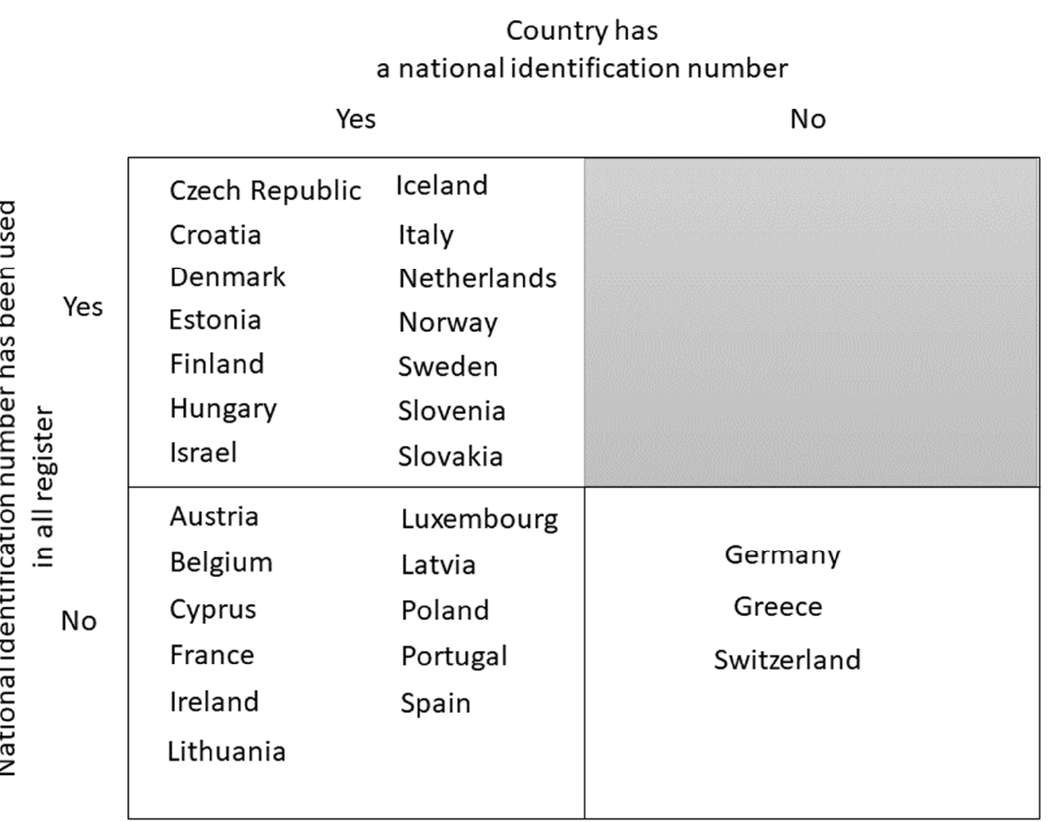
Figure 5. Availability of national identification number and its use in different registers.